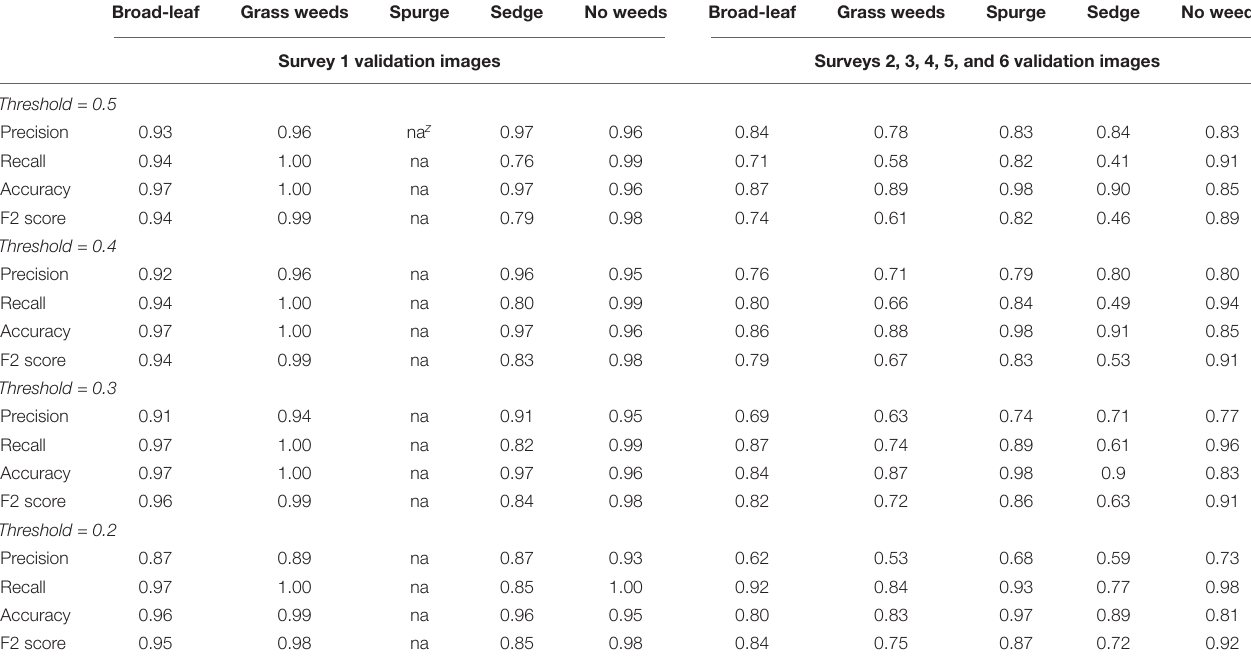
TABLE 3 | Validation results from survey 1 to the other 5 surveys of the multiple-class neural network trained using architectures ResNet 34 for detection of weed types in sod production fields. Broad-leaf Grass weeds Spurge Sedge No weeds Broad-leaf Grass weeds Spurge Sedge No weeds